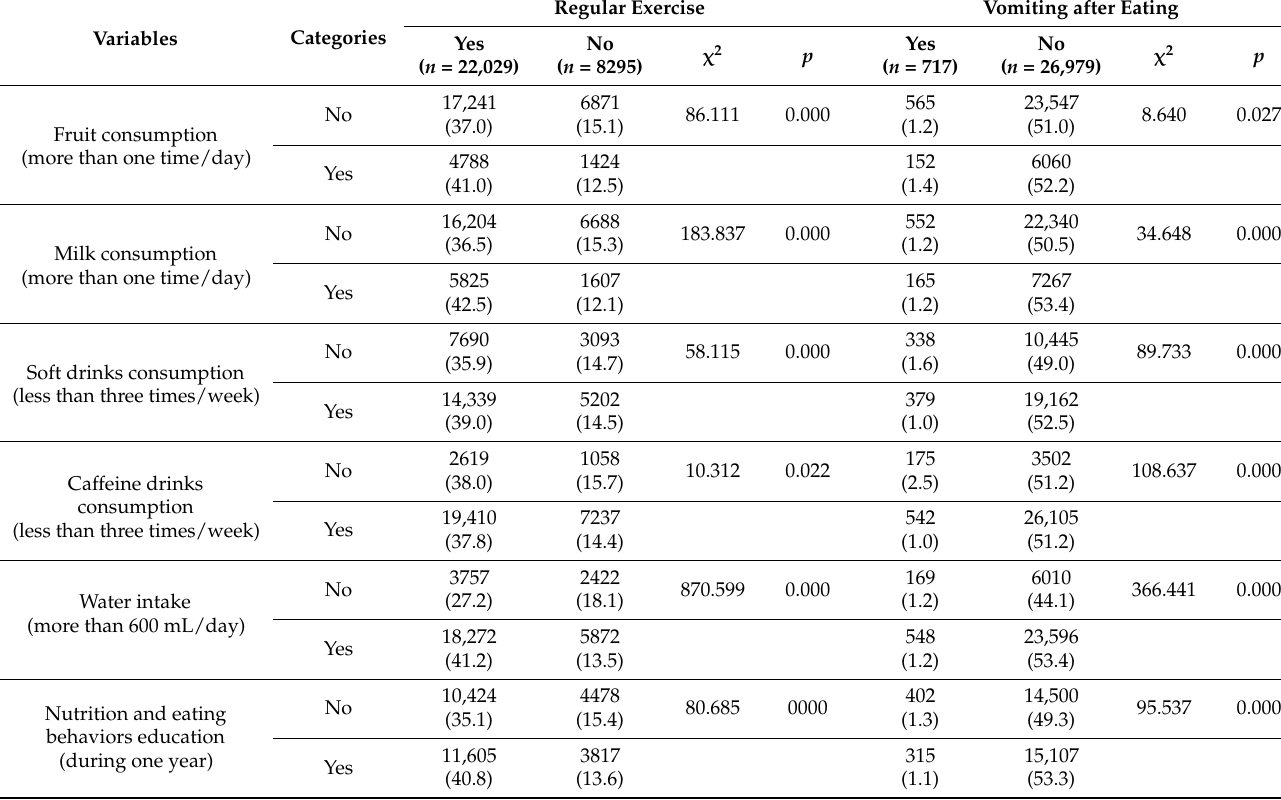
Table 2. Eating behavior according to the weight-loss methods.